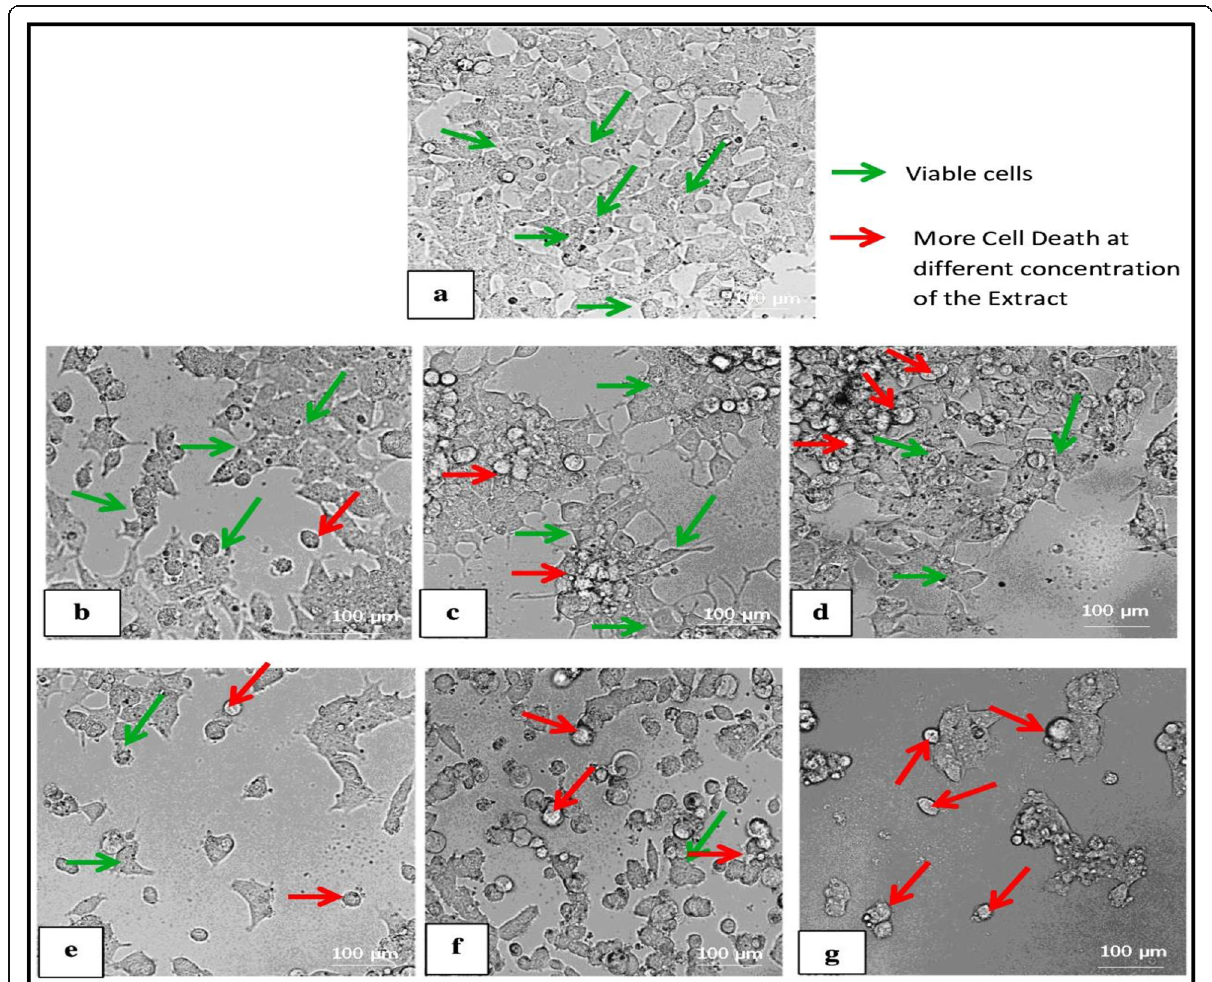
Fig. 2 Morphological profile of the MCF-7 cells after treated with ethyl acetate extract of Clerodendrum thomsoniae Balf.f. at 5.0 μ g/mL ( b ),10 μ g/